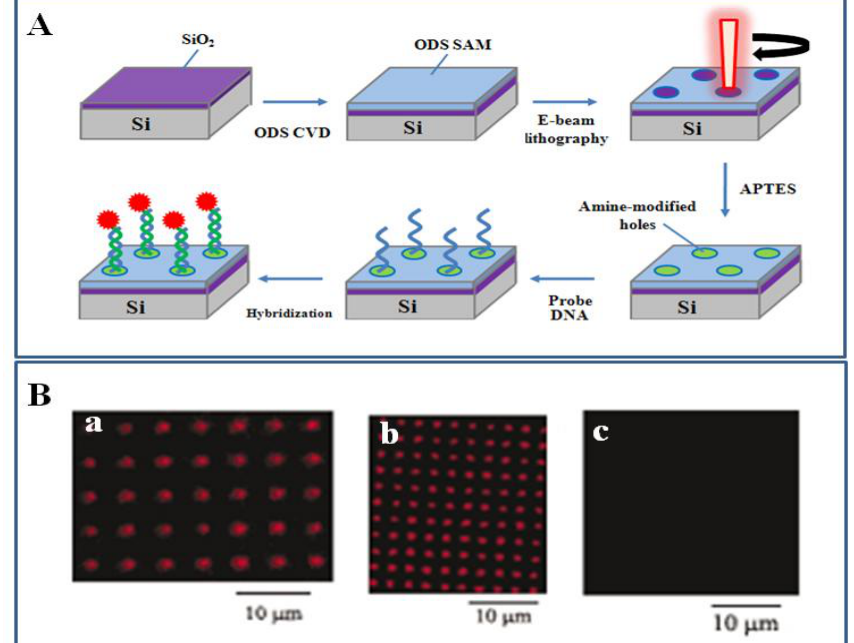
Figure 7. (A) Schematic of fabrication of nanometer-sized patterns using EBL. (B) Fluorescence micrographs of Cy 5 labeled target hybridized to probe DNA immobilized within nanodot areas fabricated by EBL on ODS SAM: (a) complementary probe DNA (spot size: 500 nm); (b) complementary probe DNA (spot size: 250 nm); (c) non- complementary probe DNA. Reproduced with permission of RSC